Question: Summarize what this figure shows in one sentence.
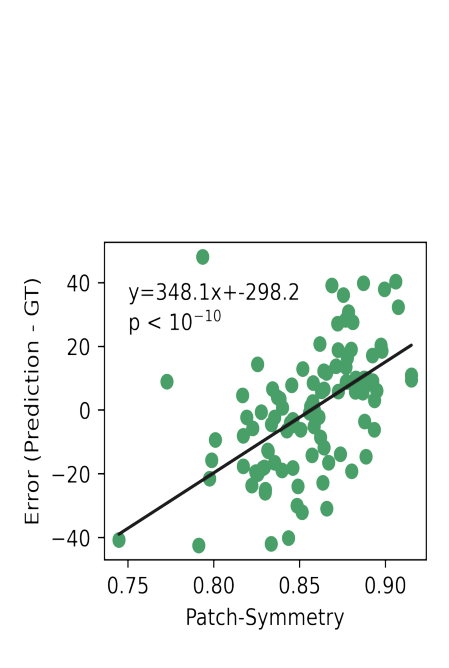
Answer: The relationship between patch- symmetry and prediction error for Sav. Int. Model overprediction (indicated by posi- tive prediction error) occurs when patch- symmetry is high. Linear regression re- veals a significant Pearson correlation of 0.51.